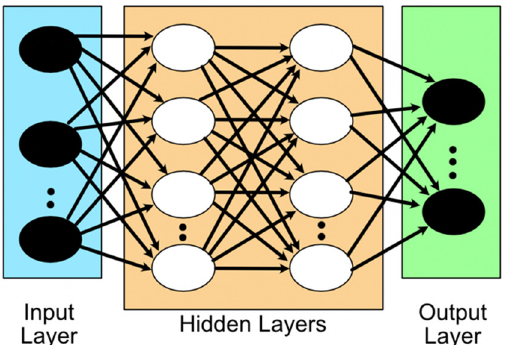
Figure 3. Clustering of multiple signals that represent interesting scenarios.